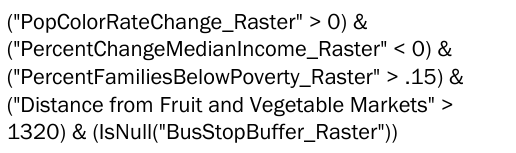
Figure 4. Raster Calculator Expression Used To Determine Best Locations for Produce